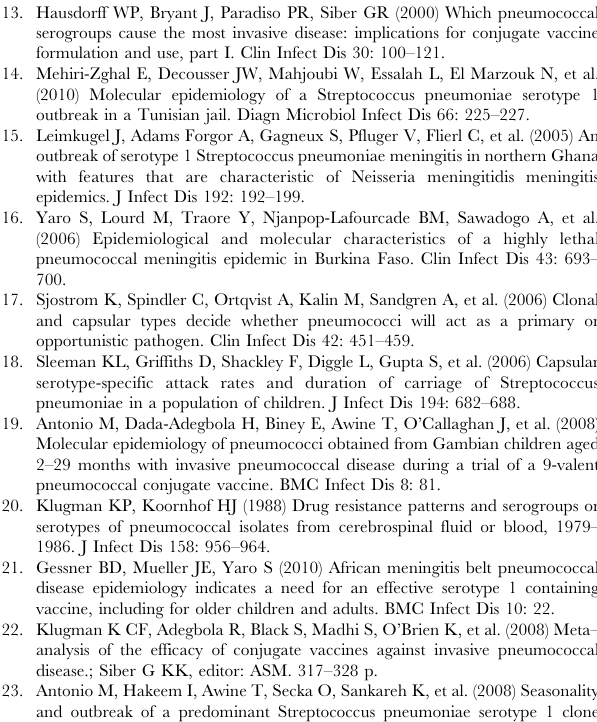
Table S1 Detection of Virulence Genes. An exhaustive literature search revealed 313 pneumococcal proteins shown to contribute to virulence in animal models and culture assays. The presence of each of the virulence-associated proteins was determined for each of the 12 fully sequenced S. pneumoniae genomes. A ‘‘ + ’’ indicates the gene is present while a ‘‘ 2 ’’ indicate its absence. The core column indicates genes that were known to be part of the pneumococcal core genome prior to the introduction of PNI0373 and/or P1031 into the analysis. Table S2 Variant Detection in Core Pneumococcal Sequence – Serotype 1-specific positions. The non- repetitive, unique core sequence for the 12 complete pneumococ- cal genomes analyzed was queried for presence of variants. In particular, we searched for variants in which serotype 1 genomes,